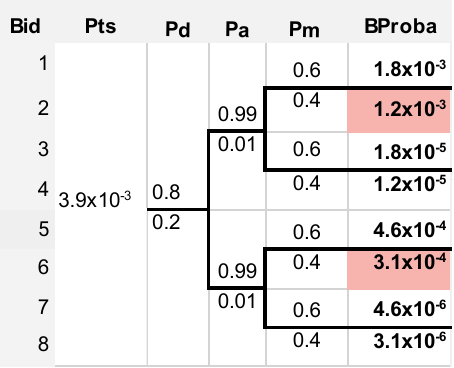
Figure 11. Event tree for the intrusion of an unauthorized drone in LIMC 35 departure path (<1 km from runway) when take-off is occurring.